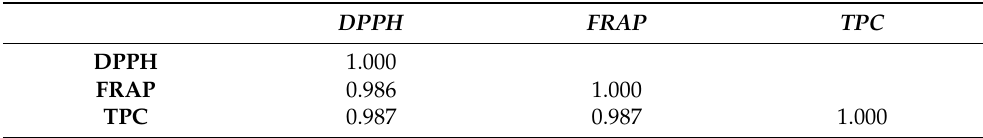
Table 1. Correlation ( r ) between total polyphenols (TPC) and antioxidant activity (DPPH and FRAP assays) for the blackberry extract fractions. DPPH FRAP TPC DPPH 1.000 FRAP 0.986 1.000 TPC 0.987 0.987